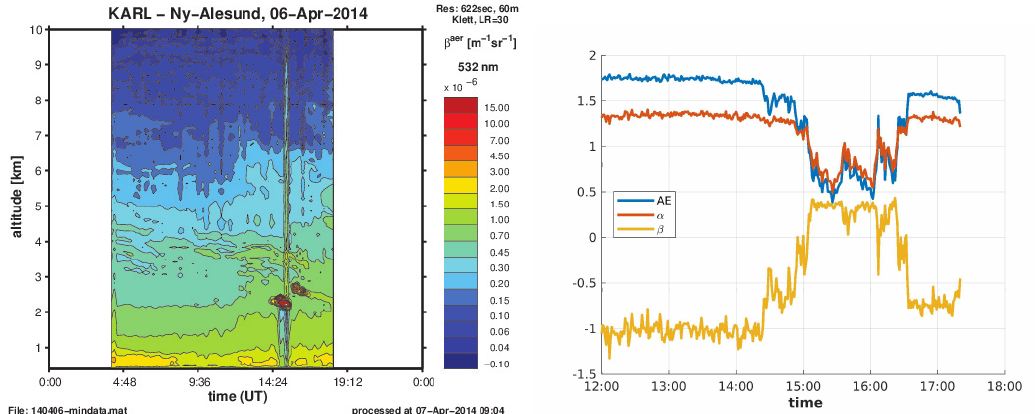
Figure 5. Example of a clear day with a small cloud appearing at 14:30 with changes in the computed Ångström parameters